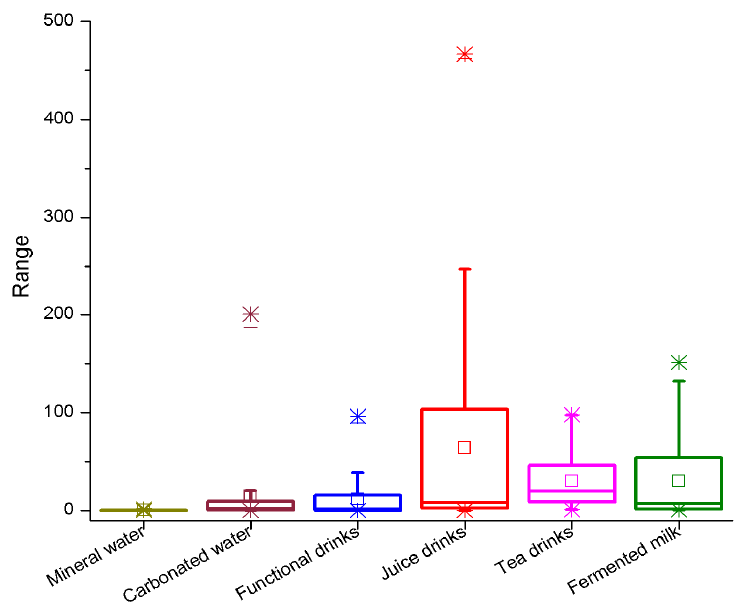
Figure 5. The distribution of the total phthalate concentration in non-alcoholic drinks.